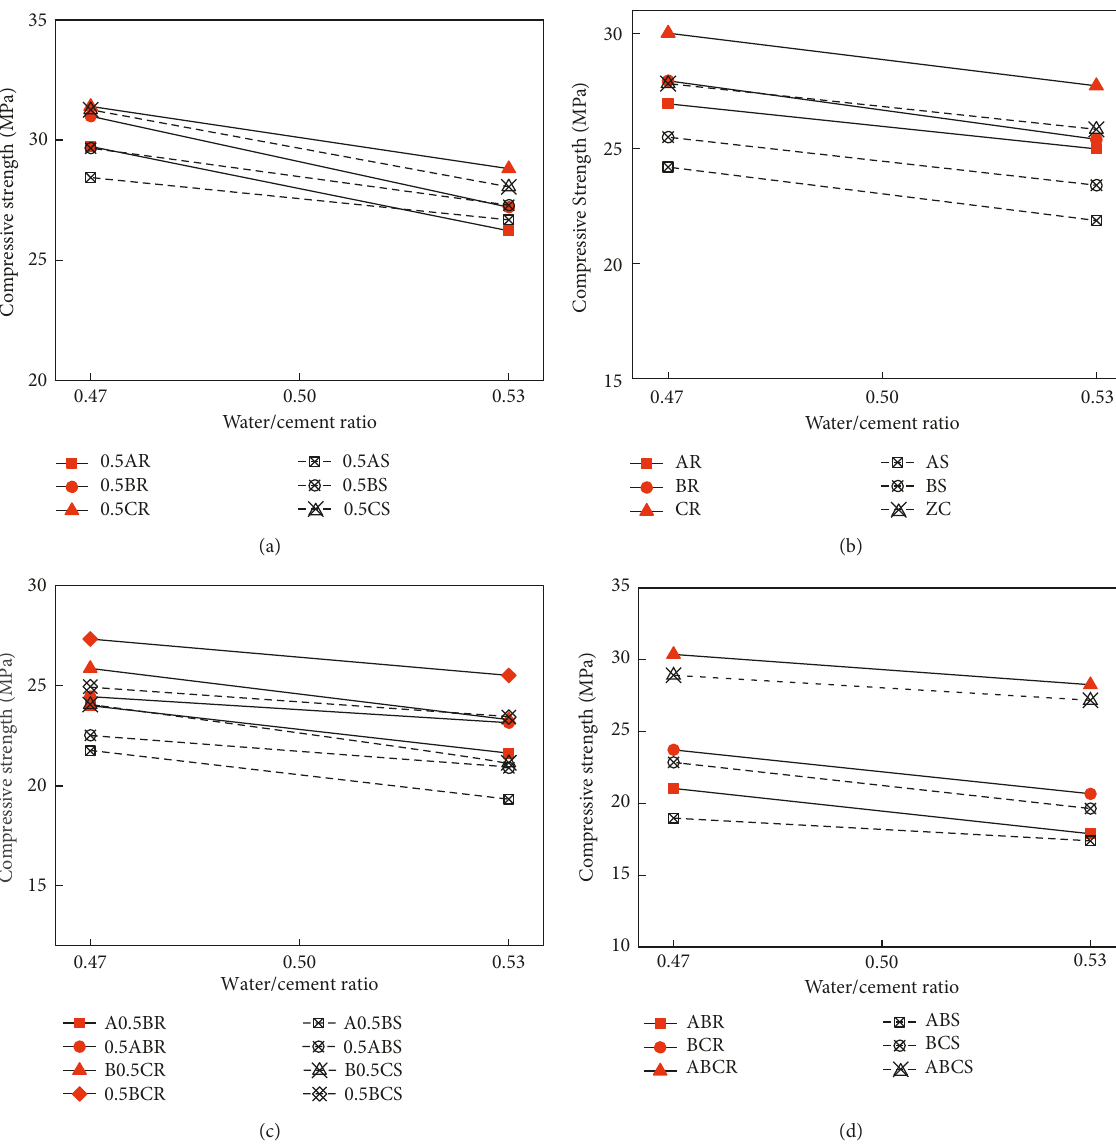
Figure 7: Relationship between the compressive strength and water/cement ratio at the same recycled aggregate content (a) 16.7%, (b) 33.3%, (c) 50%, and (d) 66.7% and